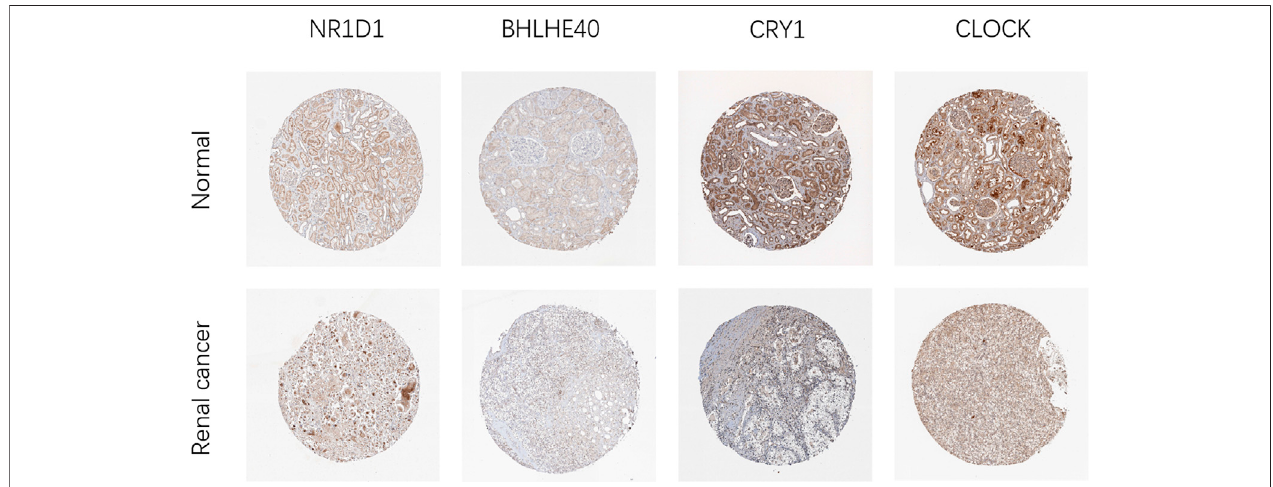
FIGURE4| RepresentativeIHCimagesofNR1D1,BHLHE40,CRY1andCLOCKexpressioninnormalrenaltissuesandrenalcancertissuesintheHumanProtein Atlas.